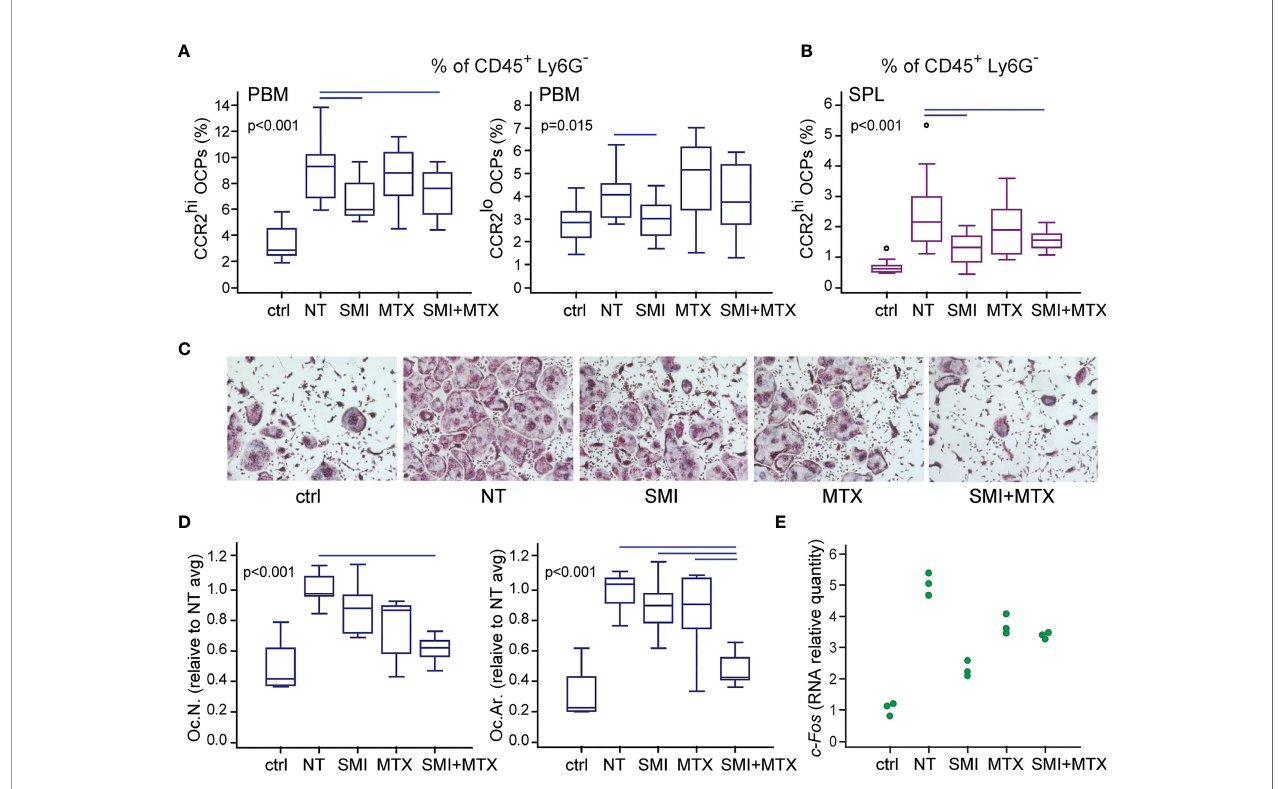
FIGURE 9 | Small-molecule inhibitor of CCR2 (SMI) alone or in combination with methotrexate (MTX) contributes to reduced osteoclast progenitor (OCP) frequency and their lower osteoclastogenic potential in DBA mice with collagen-induced arthritis (CIA). Starting approximately at day 19 (± 2 days) after the primary immunization, asymptomatic DBA mice were allocated to experimental groups [non-treated (NT) CIA, SMI CIA, MTX CIA, or combined SMI+MTX CIA] and treated every 48 h by intraperitoneal injections. Non-arthritic group was included as control (ctrl). (A) Flow cytometric analysis of the frequency of OCPs in periarticular bone marrow (PBM) bearing the phenotype CD45 + CD3 - B220 - DX5 - Ly6G - CD11b -/lo CD115 + CCR2 hi and CD45 + CD3 - B220 - DX5 - Ly6G - CD11b -/lo CD115 + CCR2 lo . (B) Flow cytometric analysis of the frequency of OCPs in spleen (SPL), bearing the phenotype CD45 + CD3 - B220 - DX5 - Ly6G - CD11b + CD115 + CCR2 hi . (C) Sorted PBM OCPs (CD45 + CD3 - B220 - DX5 - Ly6G - CD11b -/lo CD115 + ) from in vivo treated mice were seeded to plates and stimulated by receptor activator of nuclear factor k B ligand (RANKL) and macrophage colony-stimulating factor (M-CSF). Representative microphotographs of in vitro differentiated tartrate-resistant acid phosphatase (TRAP) + osteoclast-like cells are presented (magni fi cation 100×). (D) Quanti fi cation of the osteoclastogenic potential of PBM OCPs from treated mice. Culture-differentiated multinuclear TRAP + osteoclast-like cells per well (Oc.N.) and percentage of TRAP + area per well (Oc.Ar.) were calculated and normalized to the average value of NT group (NT avg). (E) qPCR analysis of c-Fos gene expression in cultures of OCPs from treated mice, stimulated by RANKL and M-CSF for 2 days, presented as relative quantity of mRNA. Dots represent technical replicates from single experiment. For (A, B, D) experiments were repeated three times and pooled data are shown ( n = 10 – 12 mice per group). Values are presented as medians (middle horizontal lines), boxes represent the interquartile range (IQR), whiskers represent 1.5 times the IQR, and outliers are represented by circles. Statistically signi fi cant difference was determined at p < 0.05, Kruskal – Wallis test ( p -value marked on the graph) with Conover post-hoc test for group-to-group comparisons; line denotes signi fi cant difference between